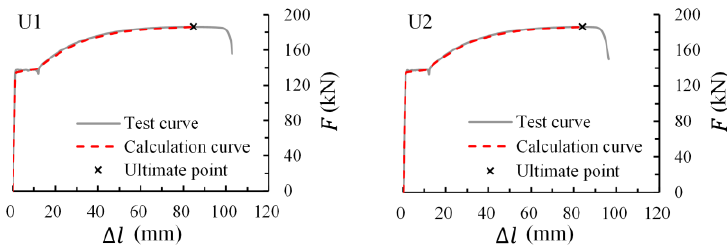
Figure 18. Calculation load-deformation curves of uncorroded rebars.